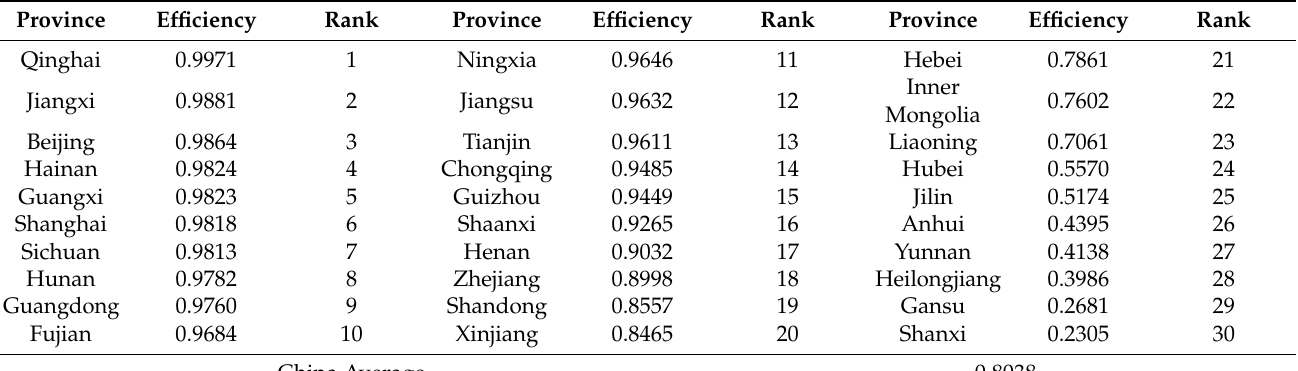
Table 2. Average ranking of ecological efficiency of agricultural land in 30 provinces of